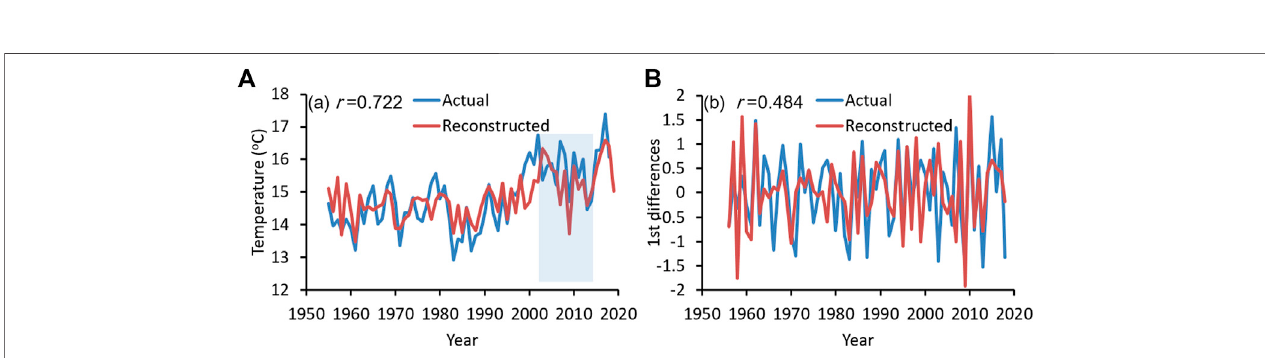
FIGURE 4 | (A) Comparison between the acutal and reconstructed mean June – July temperature for the period 1955 – 2018. (B) Comparison between the fi rst differences of acutal and reconstructed mean June – July temperature for the period 1955 – 2018. The blue shadow indicates the recent warming hiatus.